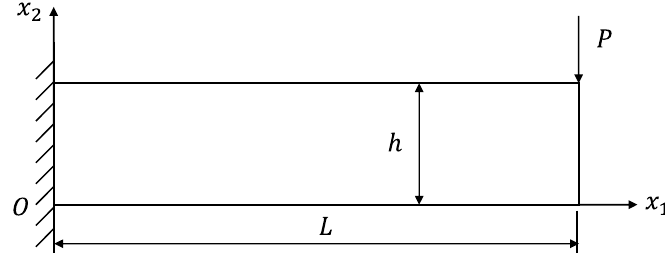
Figure 2. Cantilever beam constrained with a concentrated force.